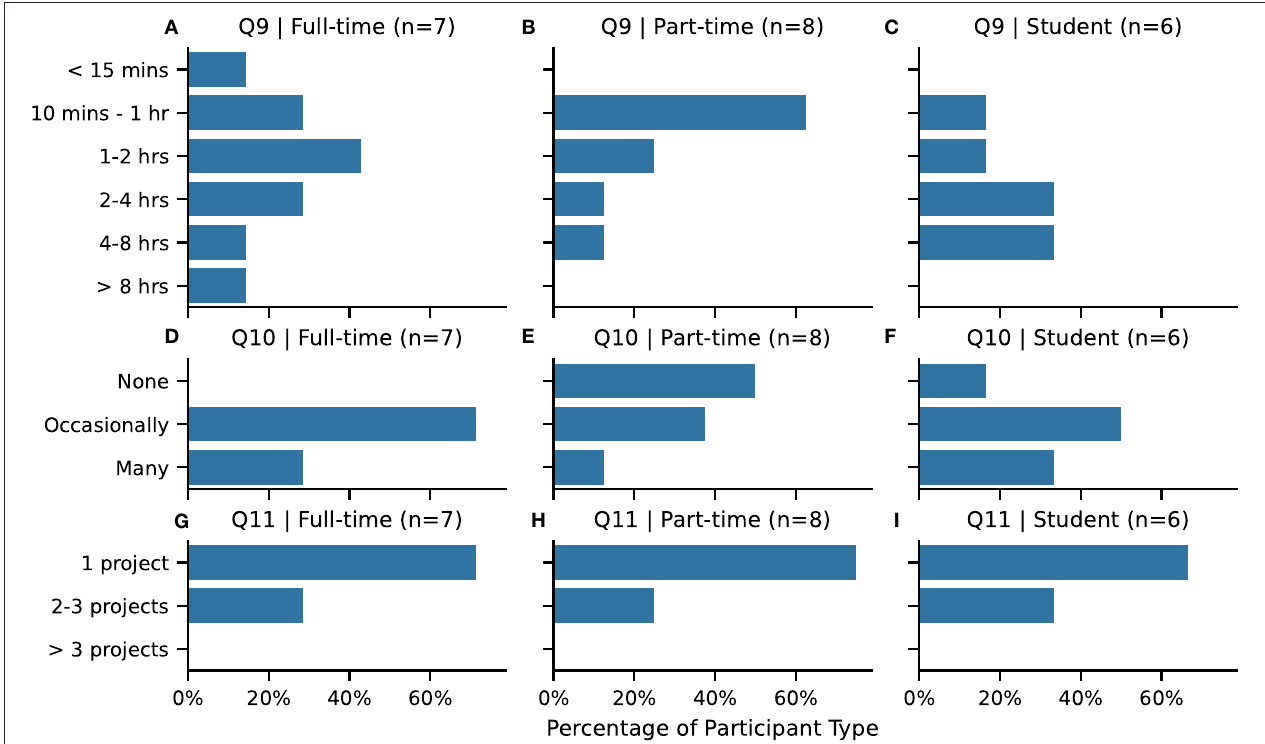
FIGURE 4 | (A–C) Q9. Duration of drawing session. (D–F) Q10. Break frequency while drawing: none or uninterrupted no breaks, occasionally take a break, take many breaks. (G–I) Q11. Project focus while working: focus on 1 or single project, switch between 2–3 projects , switch between more than three projects . Abbreviations are in bold . Participants selected one answer for each